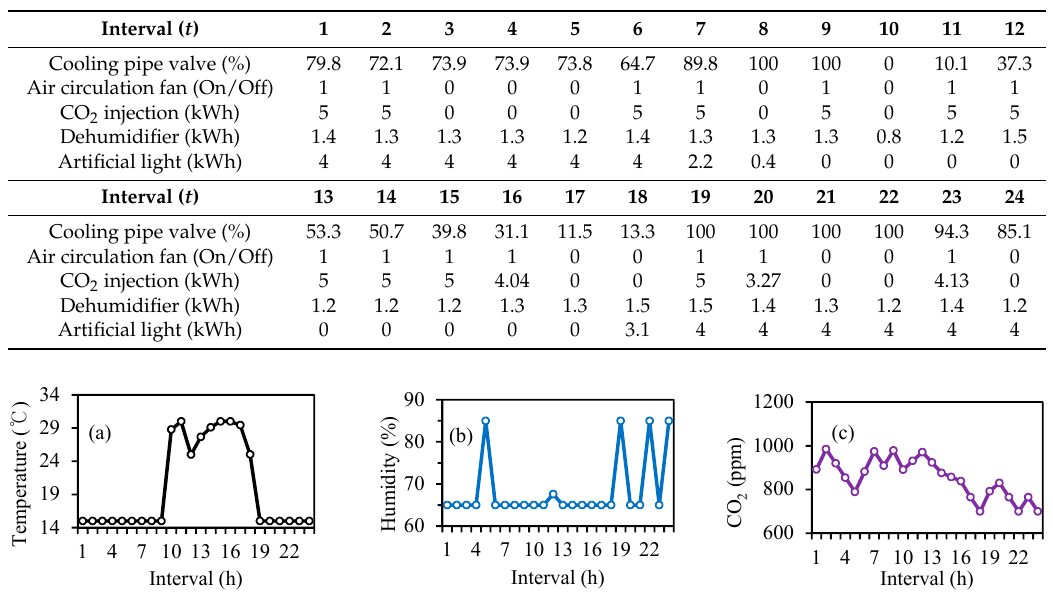
Table 5. Equipment usage for environment control during summer season in greenhouse.